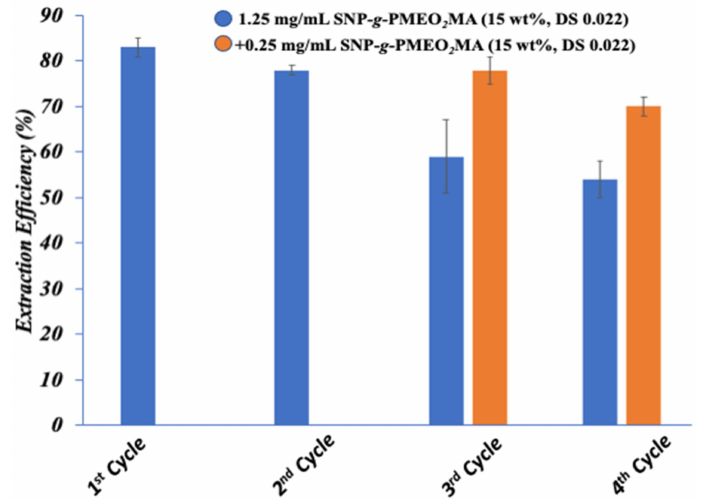
Figure 11. Polymer solution recycling in four cycles of bitumen extraction with SNP- g -PMEO 2 MA (15%, DS 0.022), with and without polymer addition in the 3rd and 4th